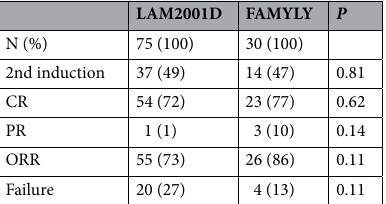
Table 3. Response to induction in the LAM2001D and FAMYLY studies. PS performance status, CR complete response, OR overall response, PR , partial response.